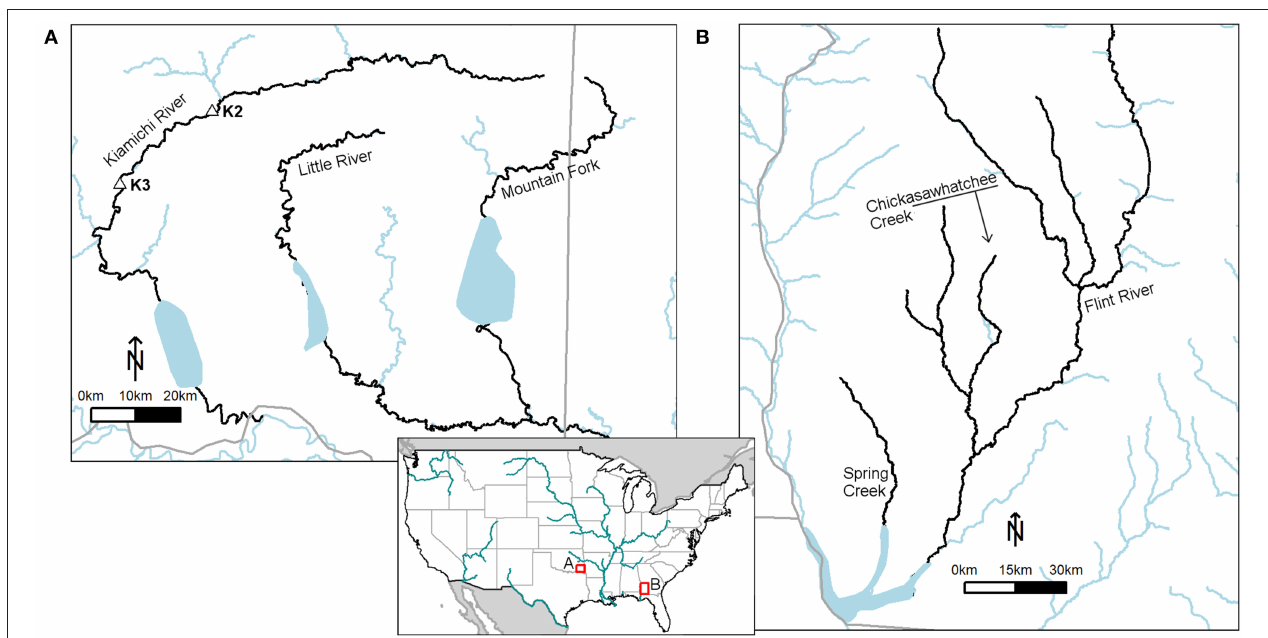
FIGURE 2 | Map of case study locations within the southern continental USA. In the bottom panel, large streams (stream order ≥ 8) are depicted in light blue to provide context while the focal river rivers are found within the red boxes. The letters next to the river basins indicate which panel corresponds to those river basins. Southeastern Oklahoma (A) contains three rivers: the Kiamichi, Little, and the Mountain Fork. K2 and K3 are sites on the Kiamichi discussed in the ‘short and long-term nutrient releases following bivalve mortality’ section of this manuscript. The lower Flint River (B) is in southwestern Georgia; rivers discussed in the case study section are named. Code from the R package hydroMap (DeCicoo and Blodgett,